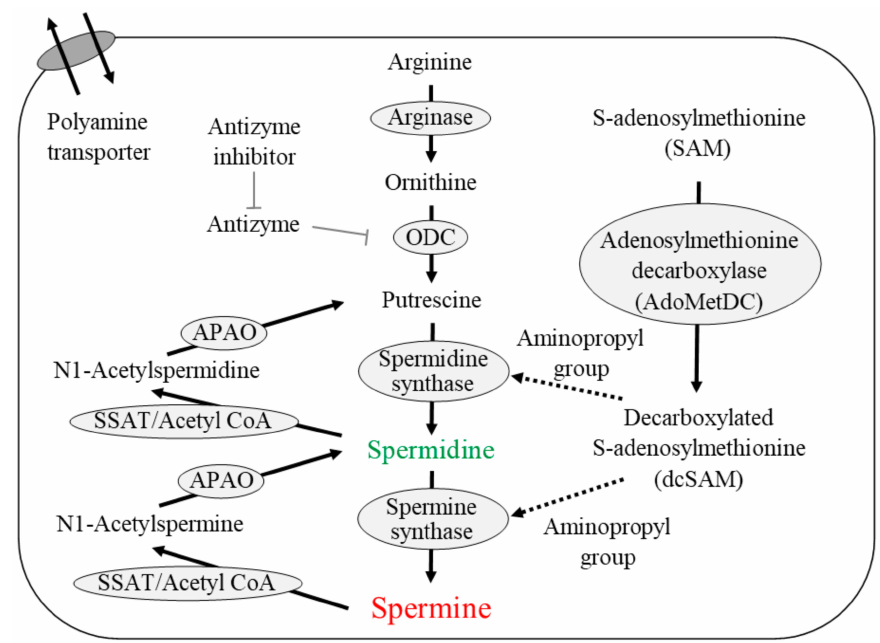
Figure 1. Polyamine synthesis, degradation, and transport. T-bar indicates the inhibitory activity. Arrow indicates the metabolic pathway or flow of substances. Dashed arrow indicates the supply of aminopropyl group from dcSAM. ODC: ornithine decarboxylase; SSAT: spermidine/spermine N 1 -acetyltransferase; APAO: N 1 -acetylpolyamine